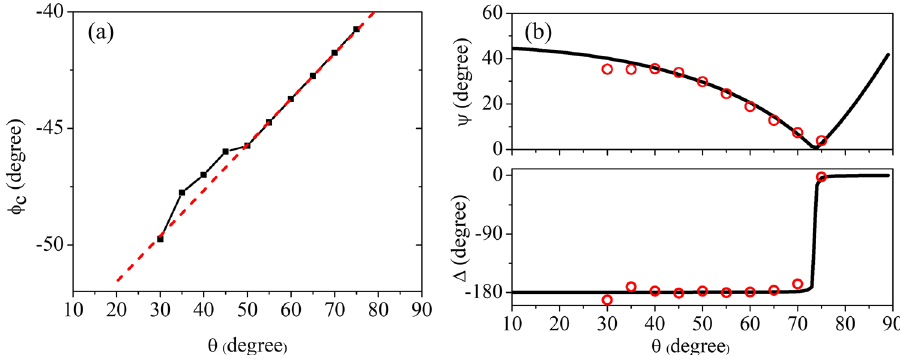
Figure 4. ( a ) Calibration curve for high resistivity monocrystalline Silicon. Values of φ c are obtained for different θ using the algorithm-assisted method in time domain, ( b ) Comparison between experimental values (red full circles) and theoretical expectations (black continuous curves) of (cid:31) and (cid:31) vs θ in Silicon at 0.4 THz.